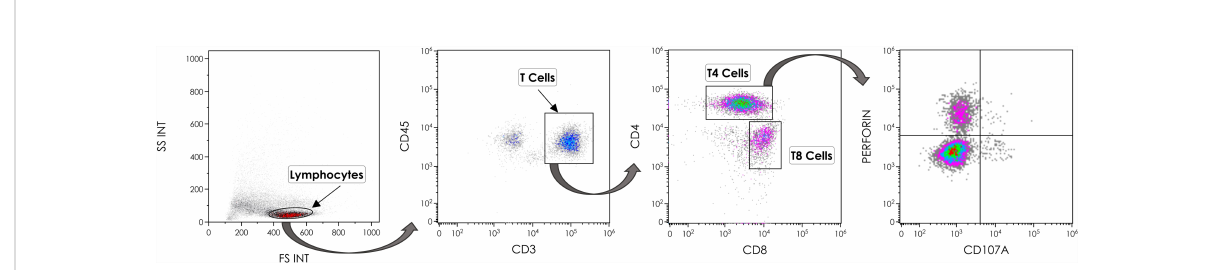
FIGURE 1 Gating strategy for the identi fi cation of T4 cells expressing perforin and/or